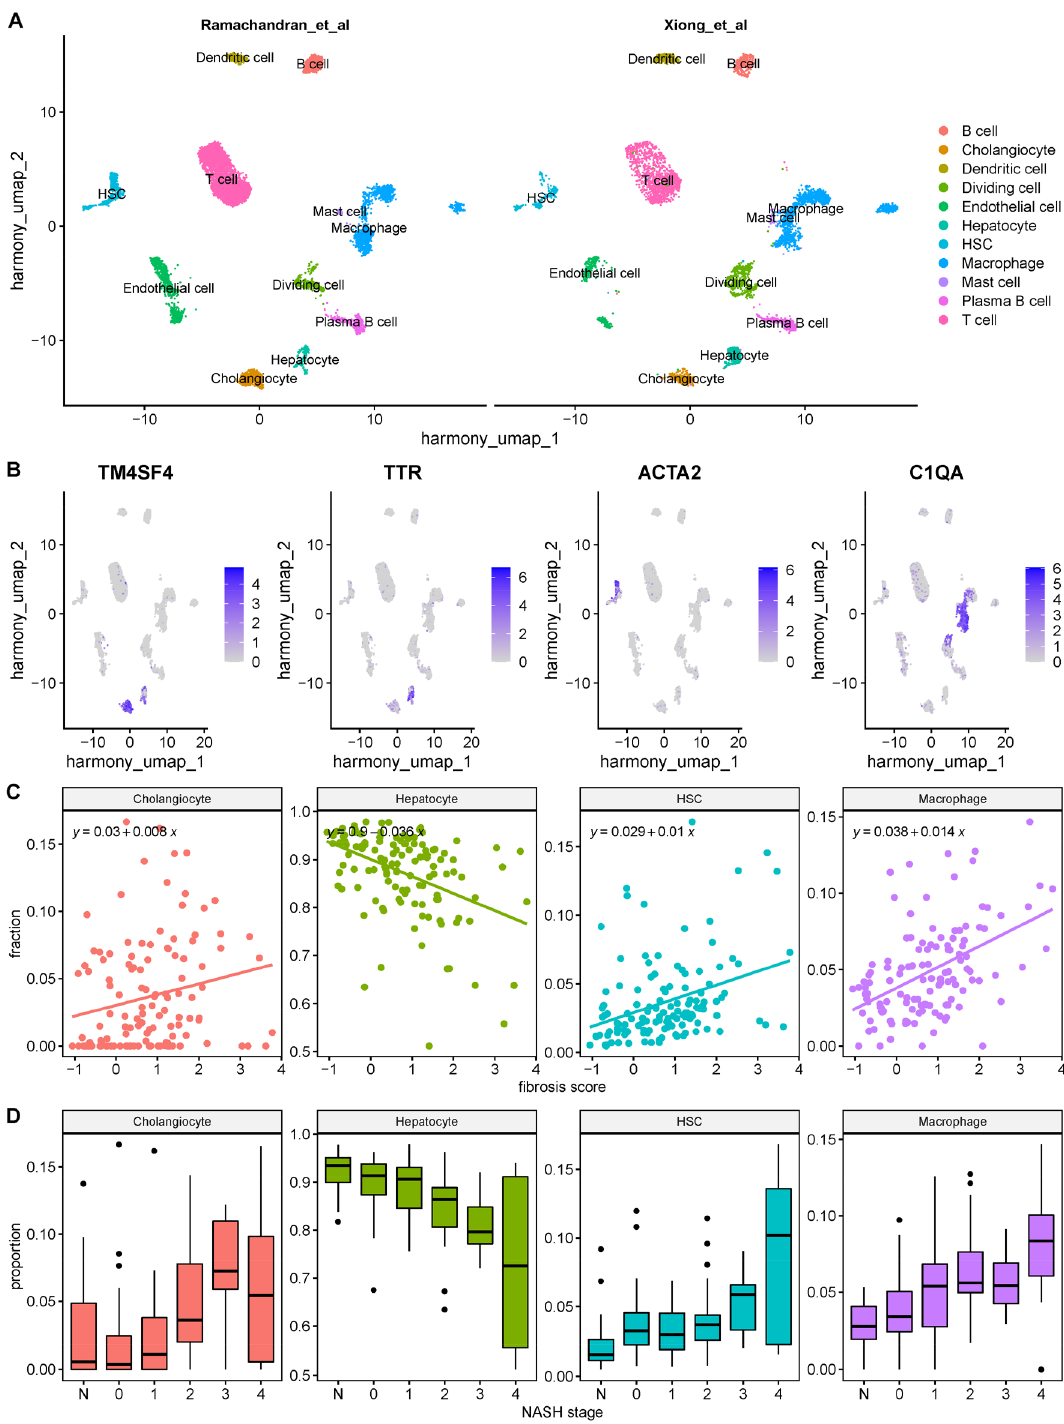
Figure 3. Cell composition deconvolution of the liver bulk RNA-Seq data. ( A ) Combined and integrated single cell reference data set (split UMAP view). The previously published human (11) and mouse (25) data sets have been re-analyzed, re-annotated, filtered for conserved cell types in both data sets, and finally aligned. ( B ) Validation of cell type annotation in the combined single cell reference by cell type-specific marker genes for Cholangiocytes, Hepatocytes, Hepatic Stellate Cells, and Macrophages. ( C ) Correlation between predicted cell type fraction and the continuous fibrosis score (ImageScore). ( D ) Predicted change of cell type proportions across observed NASH fibrosis